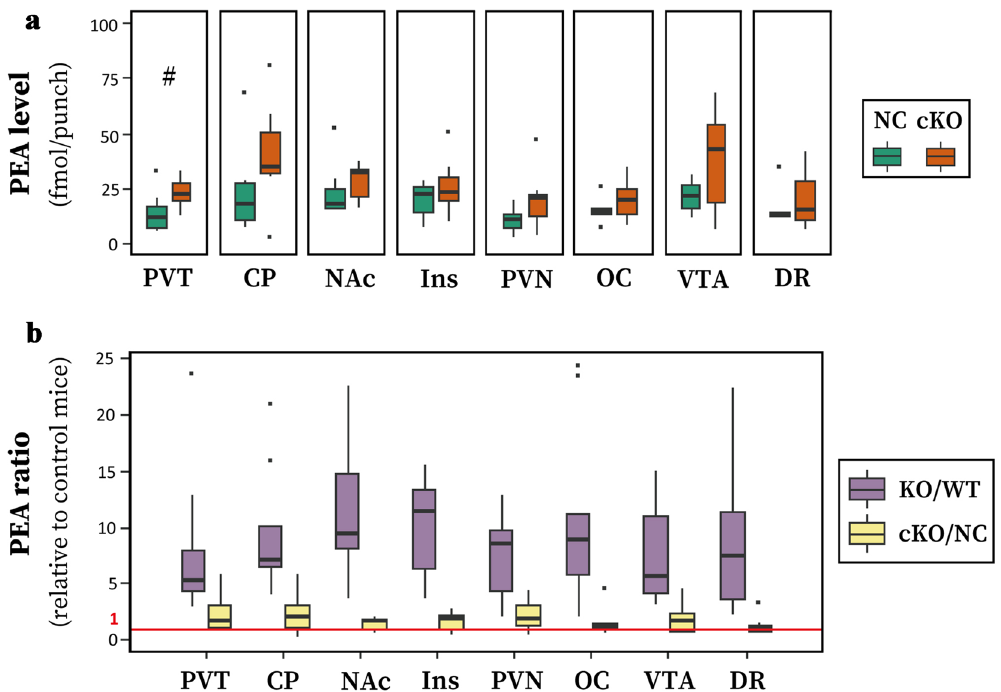
Figure 4. Potential alternation of PEA levels in brain-specific Maob KO mice. ( a ) PEA levels in the PVT and other brain regions of control Nestin -Cre (NC, Maob (+/Y); Nestin (Tg/+)) and brain-specific Maob KO (cKO, Maob (flox/Y); Nestin (Tg/+)) mice ( n = 7 for each group). # P = 0.076 by Student’s t -test. ( b ) The ratio of PEA levels in Maob KO mice to those in control mice. PEA ratios in each region of global Maob KO ( Maob (−/Y)) to wild- type ( Maob (+/Y)) littermate mice (KO/WT, n = 9) and that of cKO ( Maob (flox/Y); Nestin (Tg/+)) to Nestin -Cre ( Maob (+/Y); Nestin (Tg/+)) littermate mice (cKO/NC, n = 7) are shown. The red horizontal line indicates a ratio of 1. Two-way ANOVA showed a significant difference depending on the genotype (genotype: df = 1, F = 86.327, P = 1.43 × 10 −15 ; region: df = 7, F = 0.426, P = 0.884; and genotype × region interaction: df = 7, F = 0.597, P =